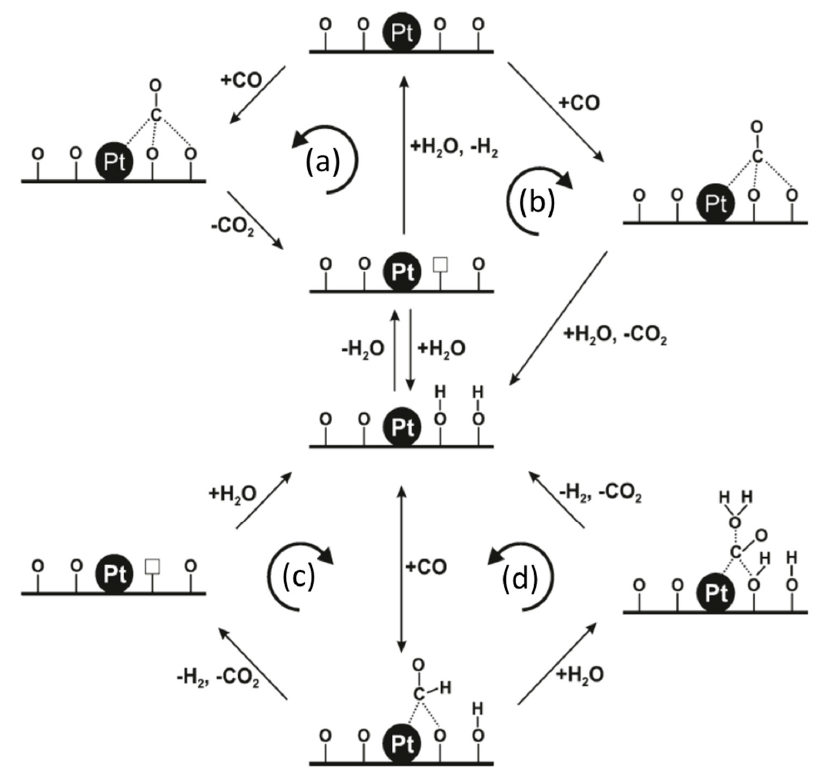
Figure 18. WGS proposed mechanisms: ( a ) redox mechanism; associative mechanism with ( b ) carbonate (CO 3 ) formation, ( c ) formate (HCOO) formation, ( d ) carboxylate (HOCO) formation. Reproduced from [116], with permission from American Chemical Society, 2011.